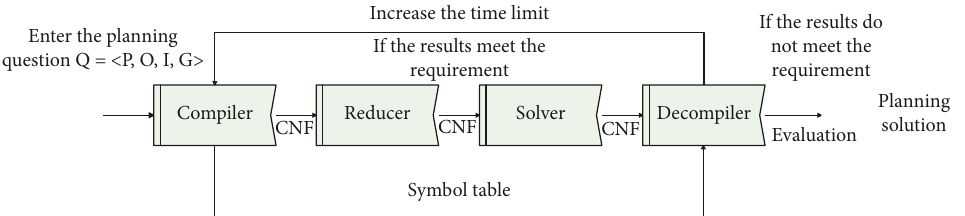
Figure 1: The planning process of the SAT system.